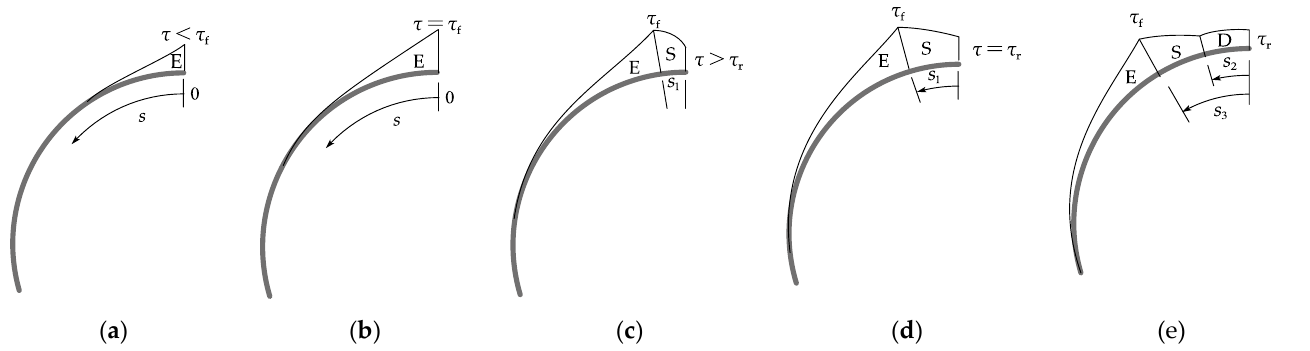
Figure 5. The evolution of interfacial shear stress distribution: ( a ) E stage; ( b ) End of E stage; ( c ) E-S stage; ( d ) End of E-S stage; ( e ) E-S-D stage.